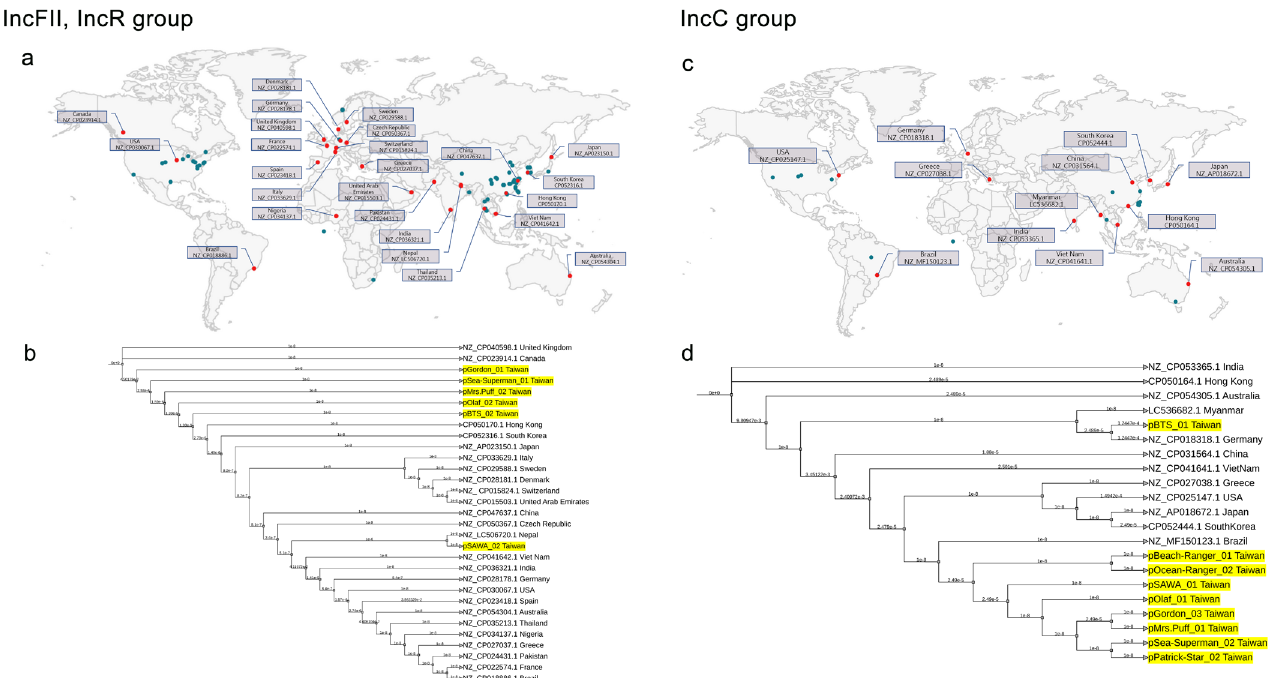
Figure 5. Global phylogeny of plasmids in CRKP reveals endemic IncC in Taiwan. ( a ) Global distribution of IncFII and IncR plasmids reveals a diverse distribution pattern among different regions. ( b ) Phylogenetic analysis of IncFII and IncR plasmids demonstrates the high diversity and evolutionary dynamics of these plasmids. ( c ) Global distribution of IncC plasmids shows that this plasmid group is prevalent in Taiwan, suggesting the presence of endemic transmission of IncC plasmids in this region. ( d ) Phylogenetic analysis of IncC plasmids reveals local clusters of related plasmids, further supporting the possibility of sustained local transmission of IncC plasmids in Taiwan.